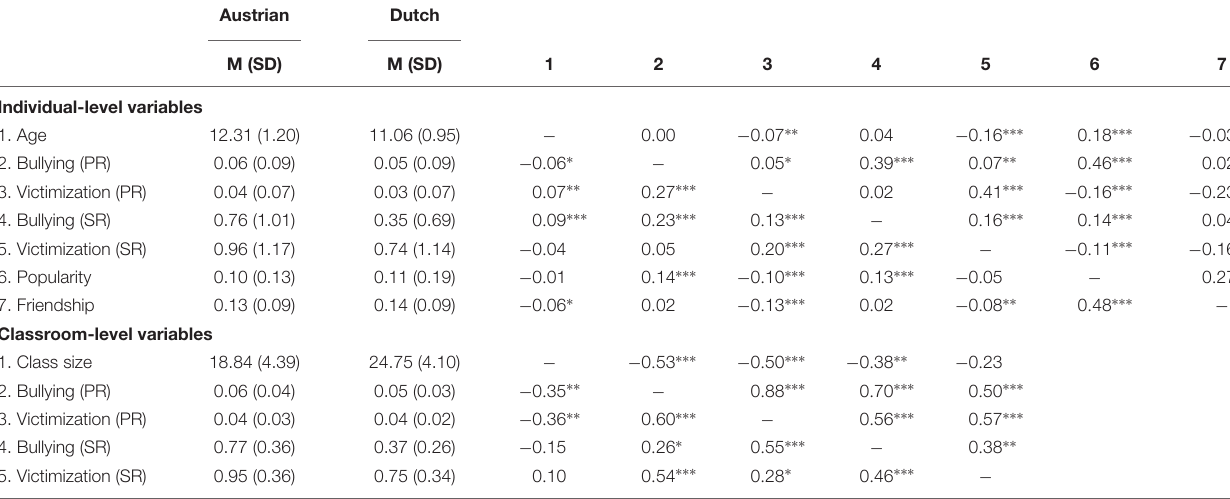
TABLE 1 | Descriptive statistics and correlations for the main study variables.